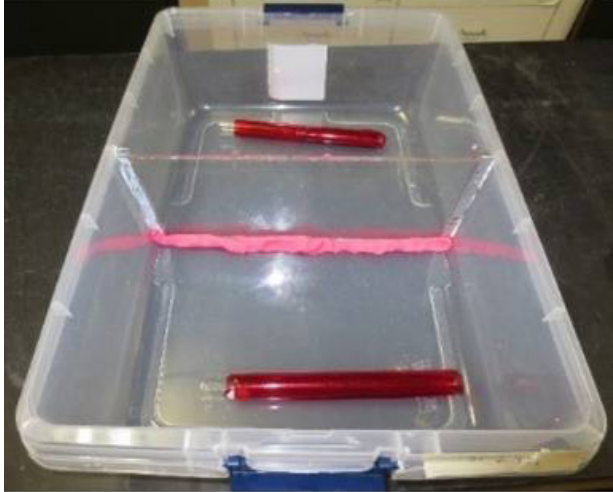
Fig 1 . Brachyponera chinensis nest emigration arena (60.9 cm x 42.6 cm x 16.7 cm) with test tube (250 mm x 25 mm) harborages, plexiglass insert, and Play-Doh® lining. Test tubes are wrapped with red cellophane paper with a moistened 8-cm sponge inserted. During experimental trials, the plexiglass insert, Play-Doh®, and one har- borage were removed allowing the ants to freely move in the